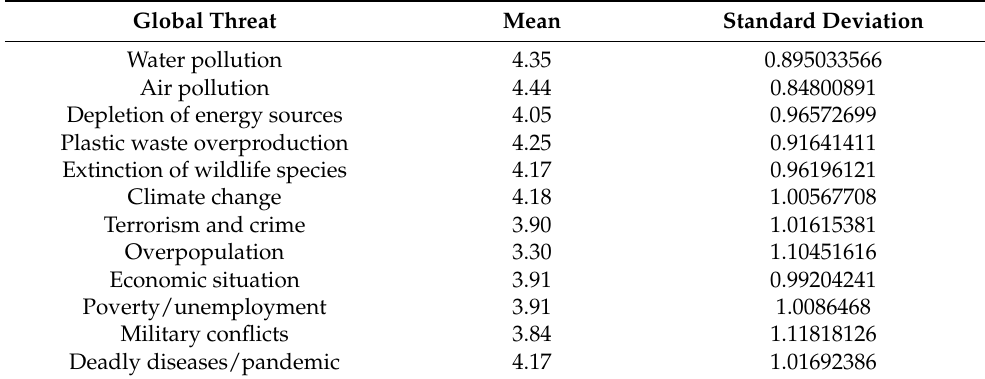
Table 2. The importance of global threats—mean and standard deviation.